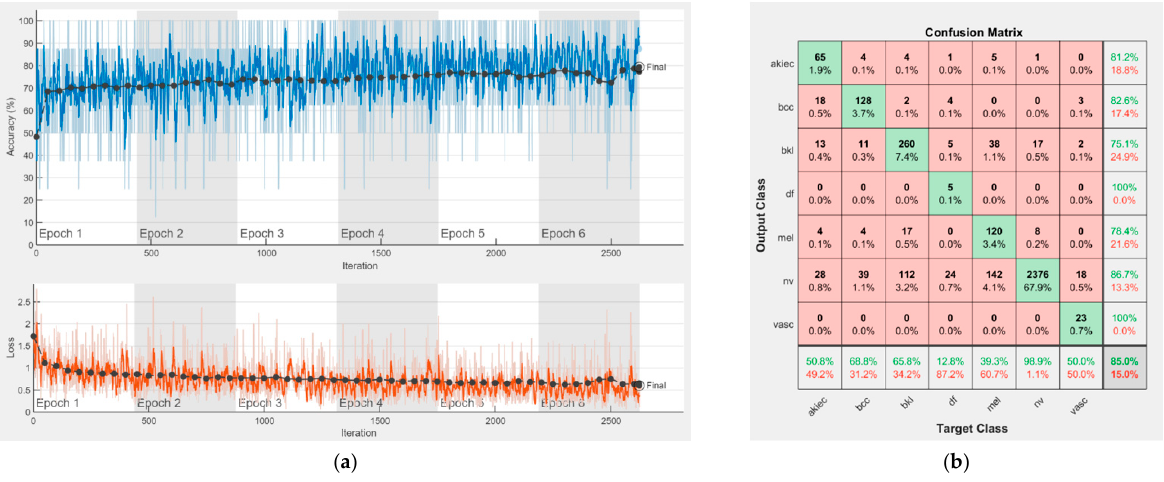
Figure 16. Results using InceptionResNet-V2, ( a ) Accuracy and loss, ( b ) Confusion matrix.